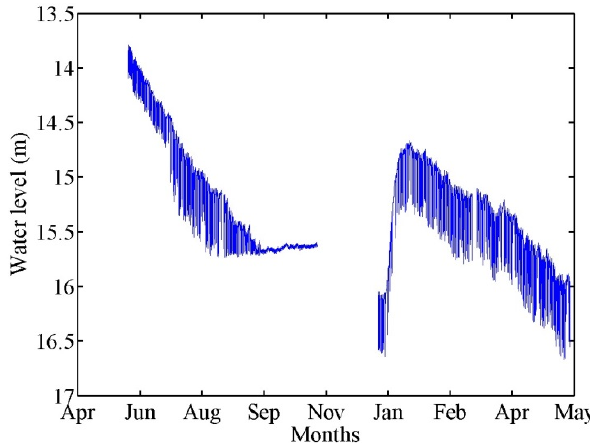
Figure 10. Water level record from a well at a farm (location in Figure 5). Note that one rainfall event was recorded in December of 2014, but water level recovery did not occur for 10 days after the event and began to rapidly recede within a few days. The missing record was caused by the removal of the transducer from the well by the farmer as it was